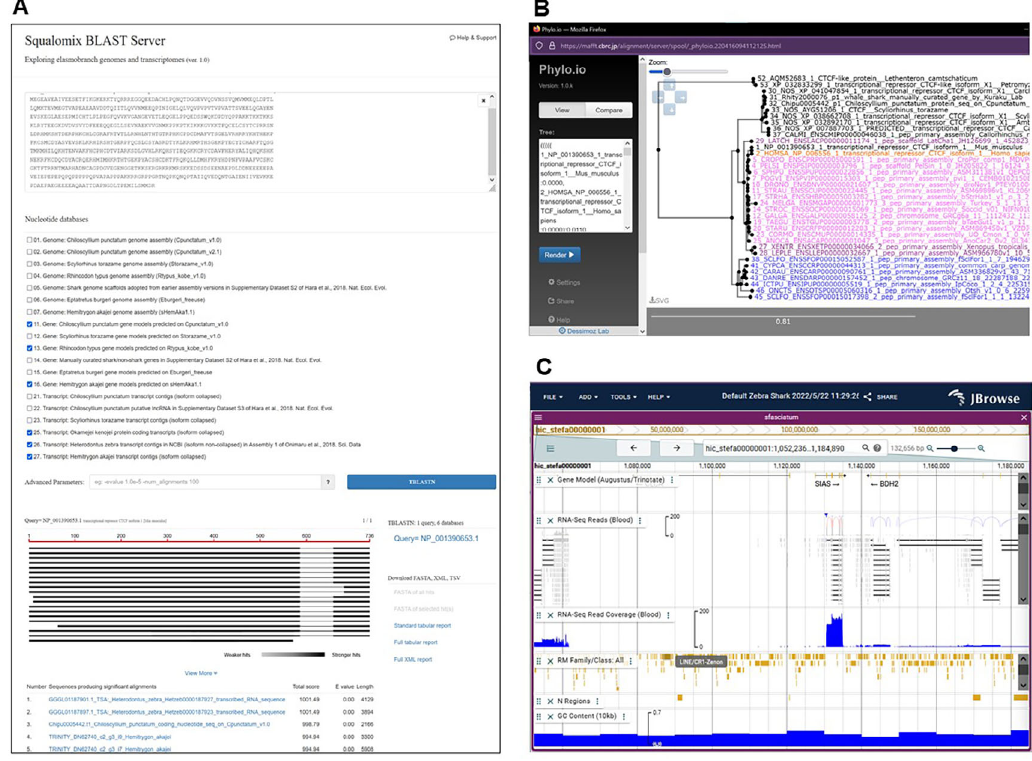
Figure 4. Overview of the Squalomix data sharing platform. A, Sequence similarity search (BLAST) in elasmo- branch genome and transcriptome sequences. B, Molecular phylogeny inference facilitated by the existing combi- nation of aLeaves (that hosts products of Squalomix) and MAFFT webservers (Kuraku et al. , 2013). C, Interactive genome browser employing JBrowse2 version 1.6.9 (Buels et al. , 2016) for the zebra shark Stegostoma tigrinum (or S. fasciatum ) based on its first genome assembly sSteFas1.1 (NCBI Genome ID, GCA_022316705.1). The websites providing these functions are found through the main consortium gateway